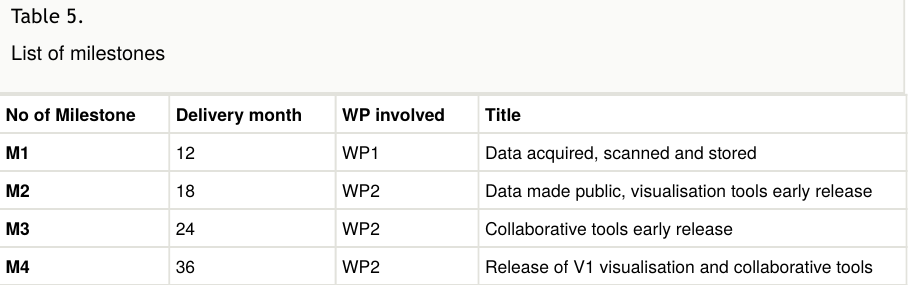
WP1 Data acquired, scanned and stored